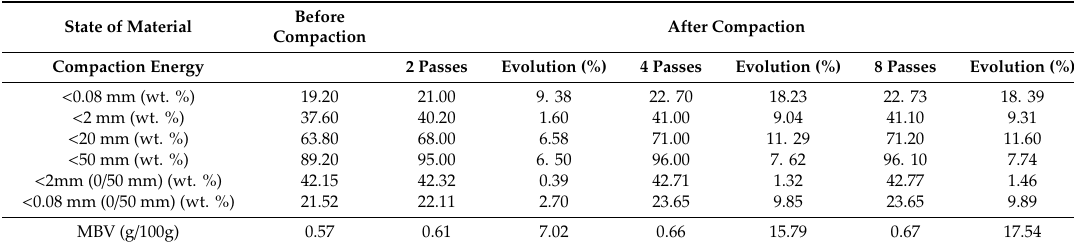
Table 4. Granulometric and Methylene Blue value (MBV) evolution according to the compaction energy. State of Material